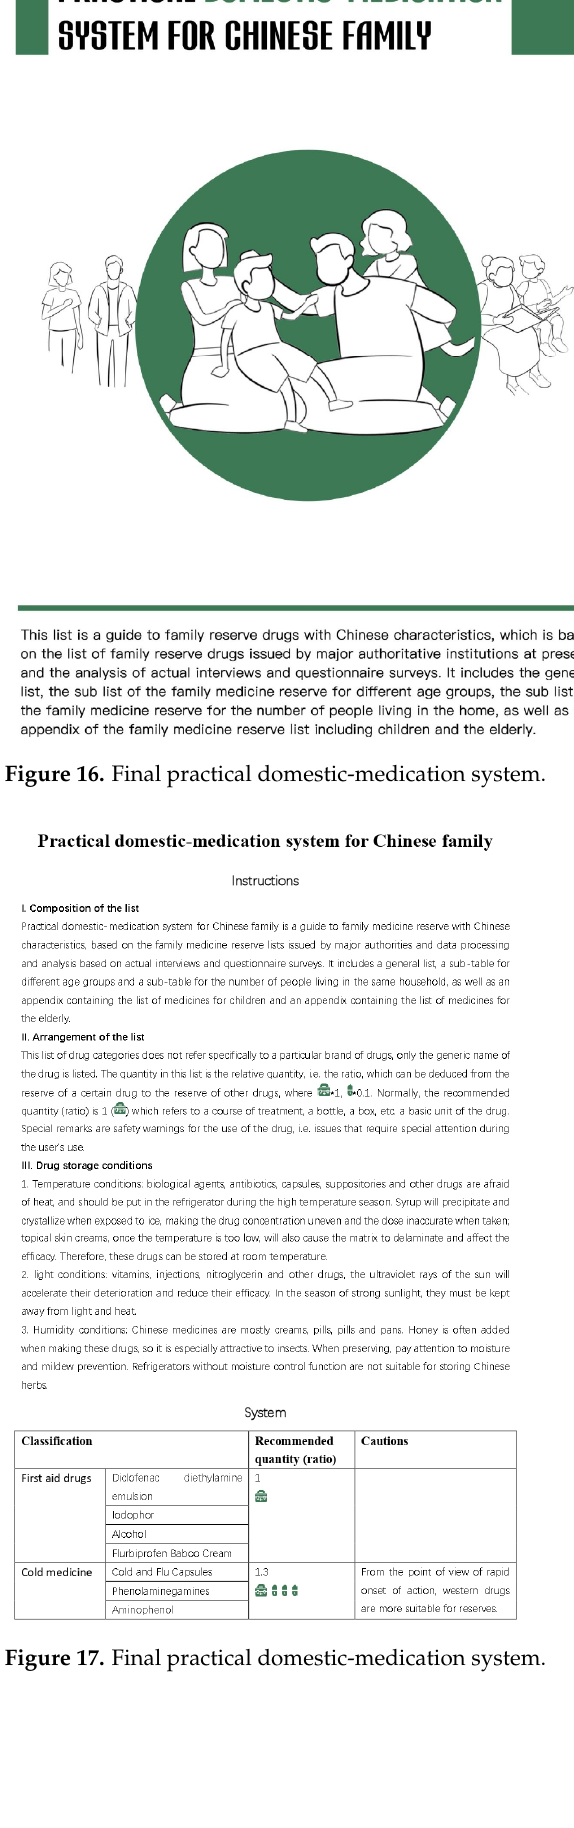
Figure 18. Final practical domestic-medication system.